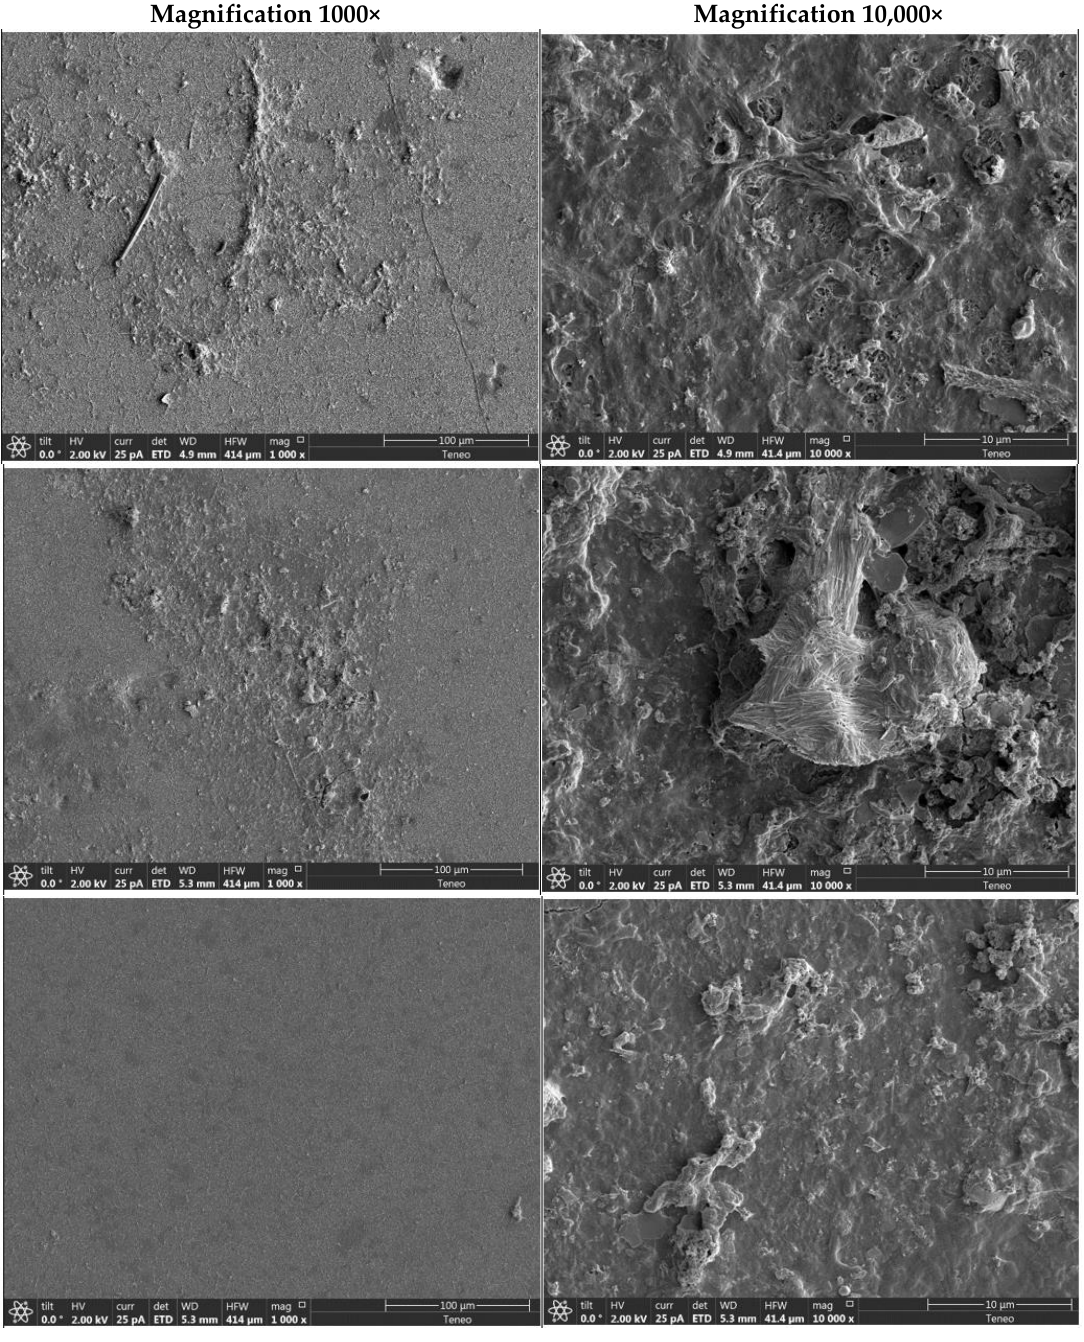
Figure 6. SEM images of the fouling surface on the uncleaned control membrane, and modules cleaned with NaOH + HCl and Urea + HCl.